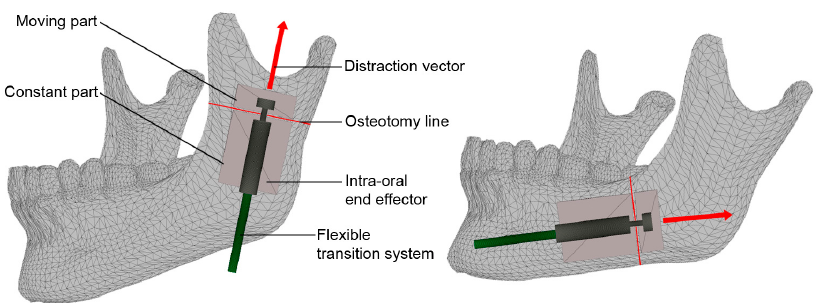
Figure 5. The application of the intra-oral bone-borne end effector.